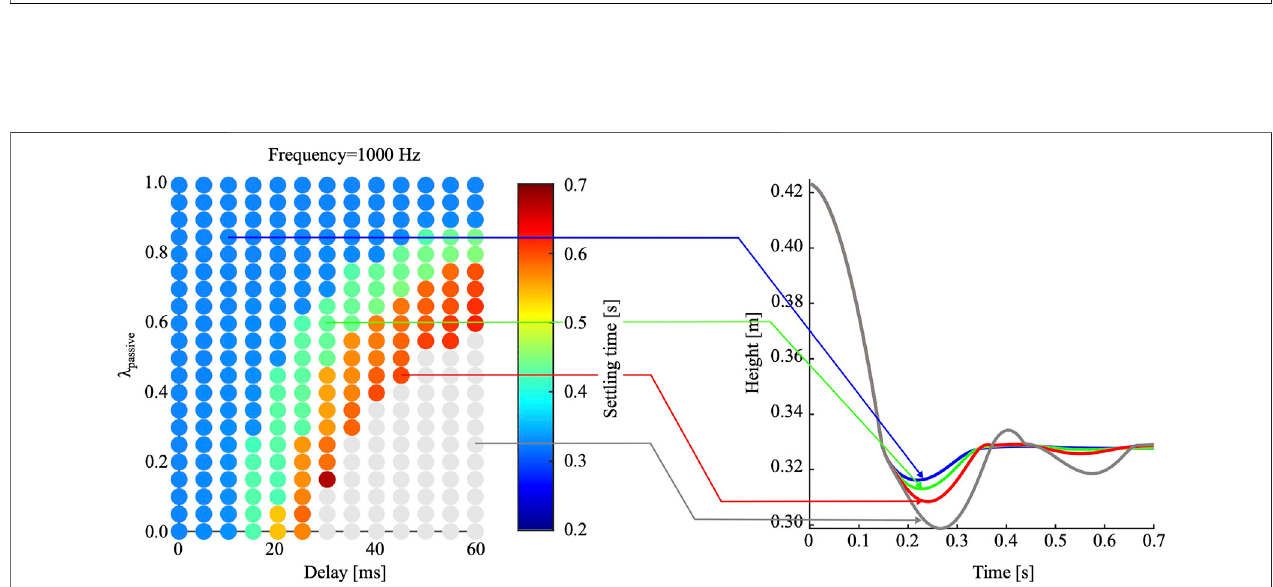
FIGURE5| Computersimulationresults:273dropsweresimulated,fortherobotlegcontrolledwithacontrolfrequencyof1,000 Hzandadutycycleof100%.The compliance ratio λ passive was varied between 0 and 1 in steps of 0.05, and the sensorimotor delay between 0 and 60 ms in steps of 5 ms. The grey data points and the grey hip height trajectory show failed landings with too large settling times. All colored data points and trajectories show successful landings. Successful landings are visible for sensorimotor delays up to 60 ms, in combination with compliance ratios of λ passive (cid:1) 0 . 6 and above.